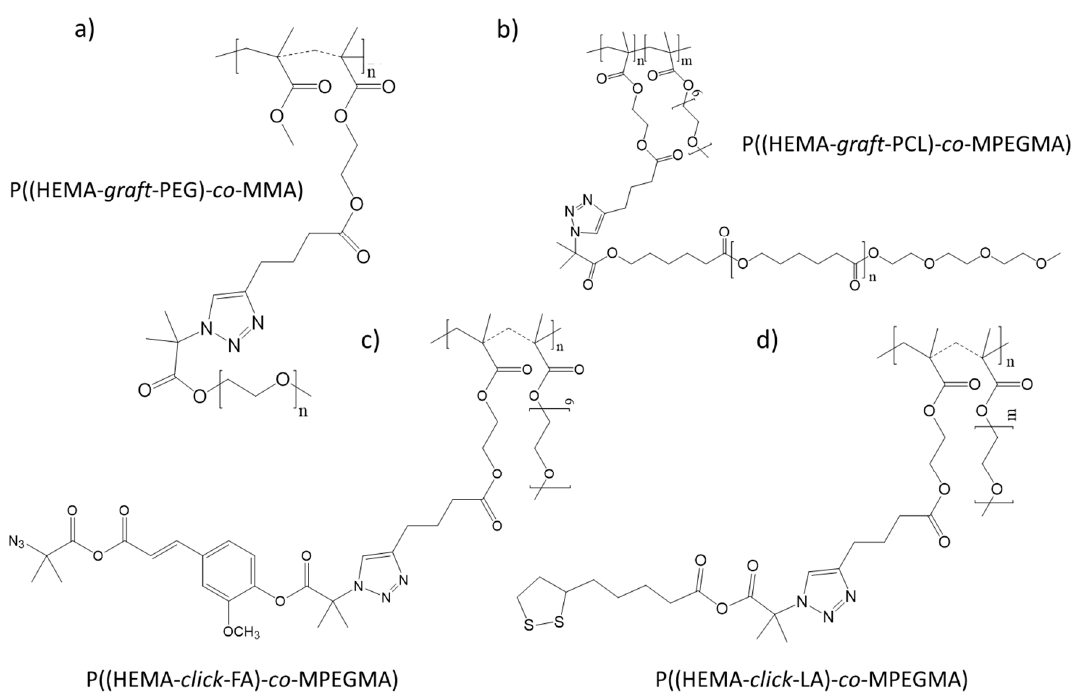
Figure 1. Structures of poly(ethylene glycol) (PEG) graft copolymer ( a ), PEG / poly( ε -caprolactone (PCL) co ‐ graft copolymer ( b ) and conjugates of PEG graft copolymer ( c , d ). Table 1. Characteristics of PEG graft copolymers.